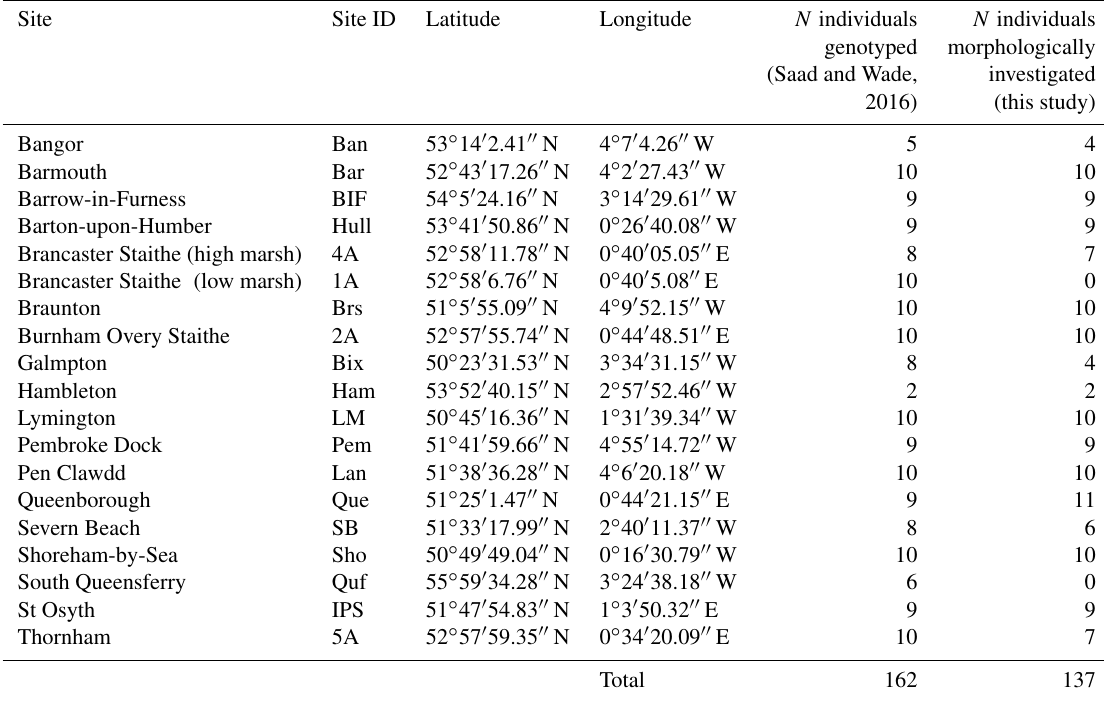
Table 1. Sites, site IDs, geographic coordinates and number of individuals which were identified genetically (from Saad and Wade, 2016) and morphometrically (this study).